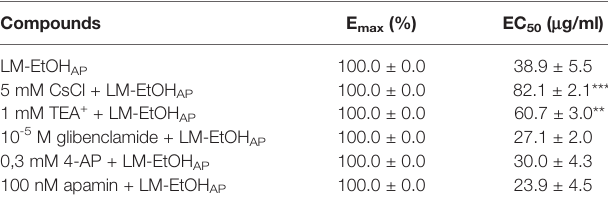
TABLE 1 | E max (%) and EC 50 ( m g/ml) values of LM-EtOH AP in both the absence and presence of K + channel blockers on guinea pig